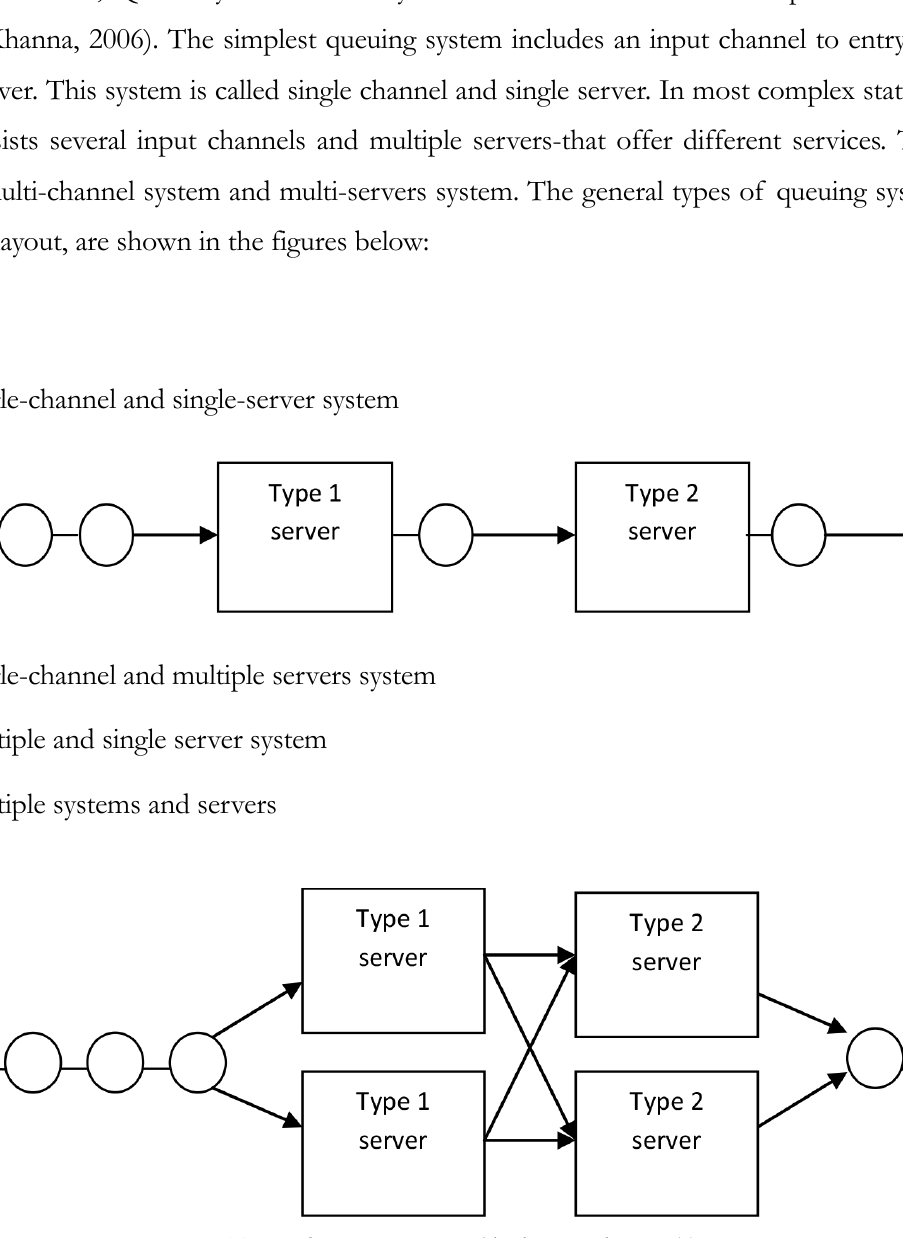
Figure 3. Types of Queue systems (Abedi, Hamidi & Parkhan,